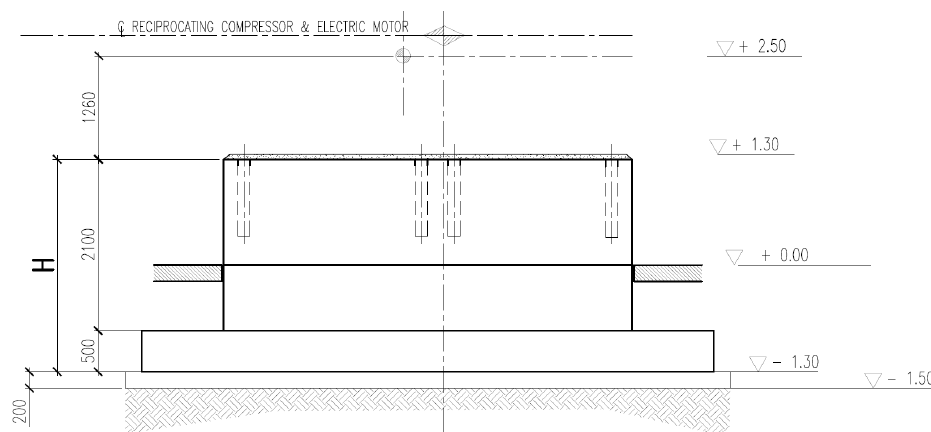
Figure 7. Top view of foundations.